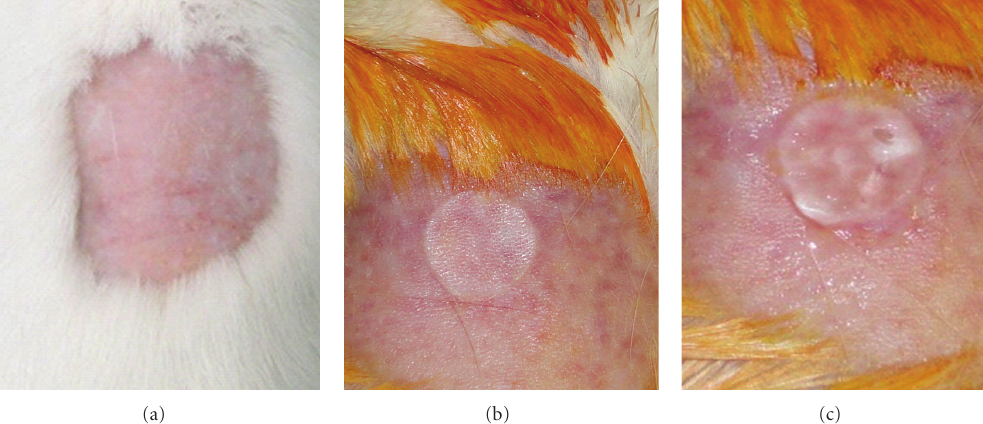
Figure 1: Induction of second-degree thermal burns in male Wistar rats. (a) Back trichotomy by direct hair tension, (b) depth second-degree thermal burn with r = 10mm, (c) treatment of thermal burn using 100 µ L hydrogel.